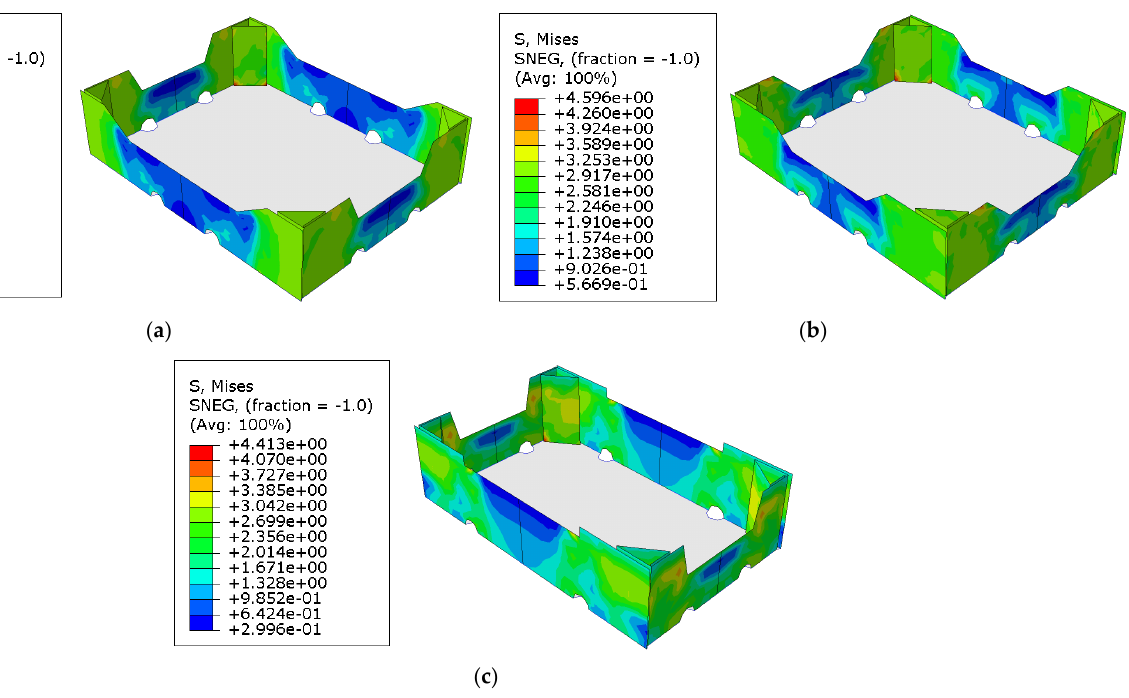
Figure 7. Stress distributions at the moment of reaching the compression load capacity of open-top boxes for storage of fruits: ( a ) case 1, ( b ) case 19, and ( c ) case 20.